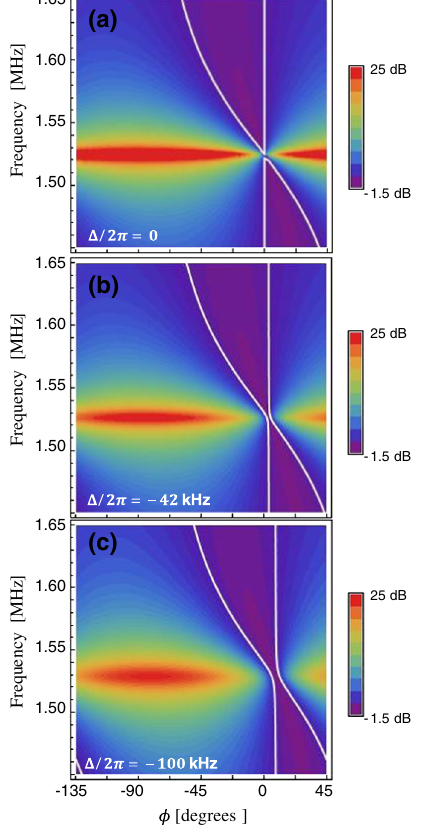
FIG. 4. Calculated homodyne spectrum for finite signal-beam detuning. Homodyne transmission spectra S three signal-beam-cavity